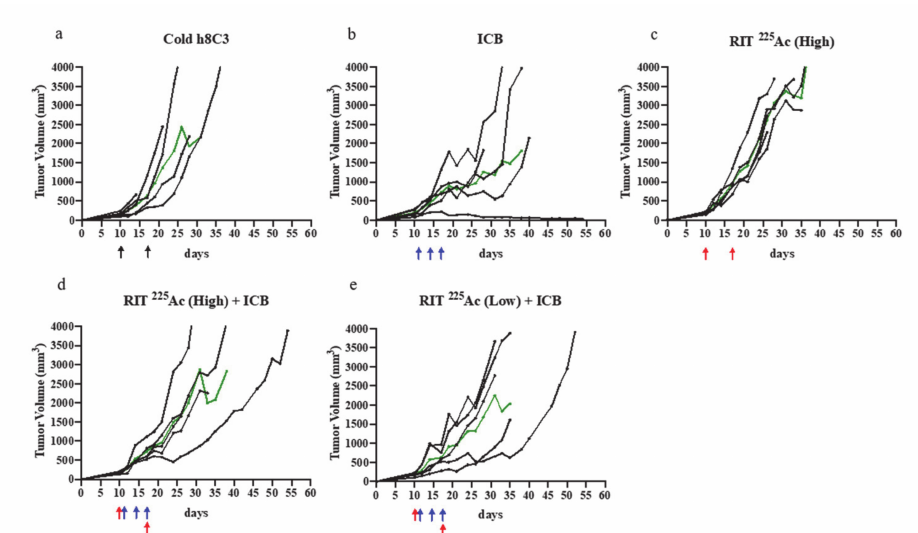
Figure 4. Combination study of anti-PD1 mAb vs. RIT with 225 Ac-h8C3 mAb. The mice in groups of five were treated with: ( a ) two doses of unlabeled (cold) h8C3 anti-melanin mAb on day 10 and 17 after S91 Cloudman tumor cell inoculation; ( b ) three doses of 250 µ g anti-PD1 mAb on day 11, 14, and 17 (ICB); ( c ) two doses of 200 nCi (High) of 225 Ac-h8C3 mAb on day 10 and 17 (RIT 255 Ac High); ( d ) three doses of 250 µ g anti-PD1 mAb on day 11, 14, and 17 with two doses of 200 nCi (High) of 225 Ac-h8C3 mAb on day 10 and 17 (RIT 255 Ac High + ICB); ( e ) three doses of 250 µ g anti-PD1 mAb on day 11, 14, and 17 with two doses of 100nCi (Low) of 225 Ac-h8C3 mAb on day 10 and 17 (RIT 255 Ac Low + ICB). Day 0 is the day of tumor cell inoculation. Each black tumor volume curve represents a single animal, green line—median tumor volume in the group. Black, blue, and red arrows indicate the injection of cold antibody, anti-PD1 antibody, and RIT, respectively.